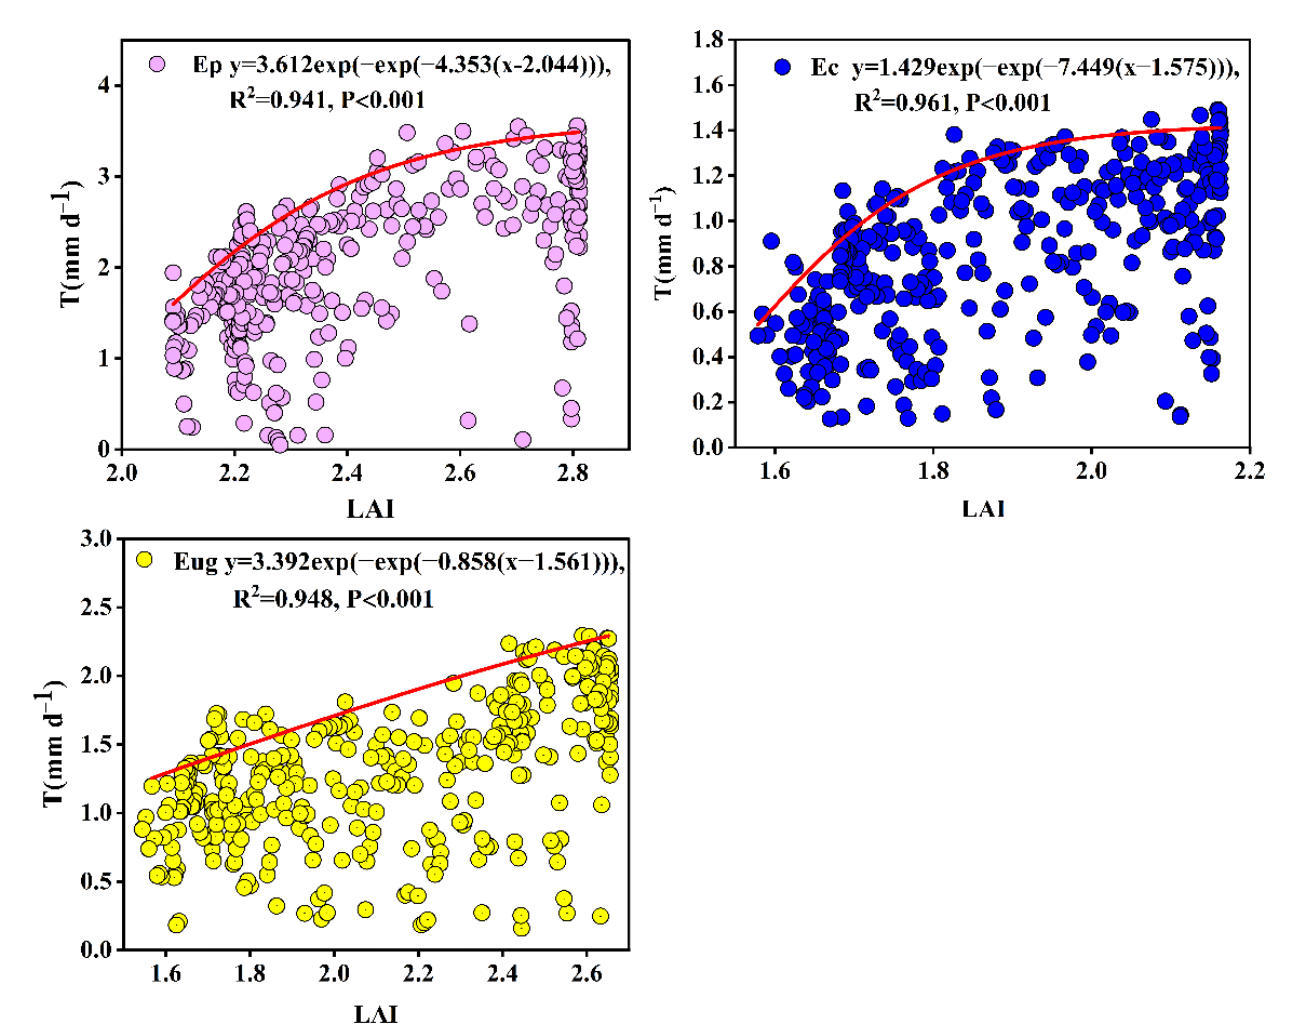
Figure 6. Response of the daily stand transpiration (T, mm day − 1 ) to the variation in canopy LAI for the three eucalyptus species (the red solid line is the upper boundary line). Ep, Ec, and Eug represent the eucalyptus species of E. pellita, E. camaldulensis, and E. urophylla × E. grandis , respectively.